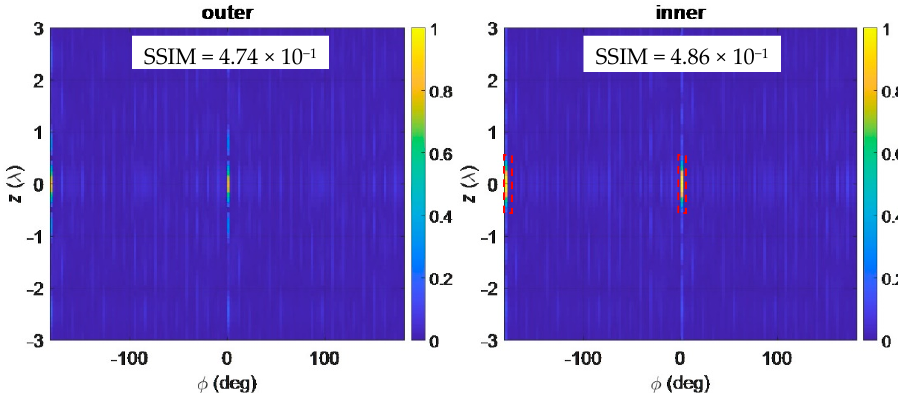
Figure 13. Reconstructed 2D images with MGs placed on the inner pipe. The red, dashed lines show the locations of the MGs.